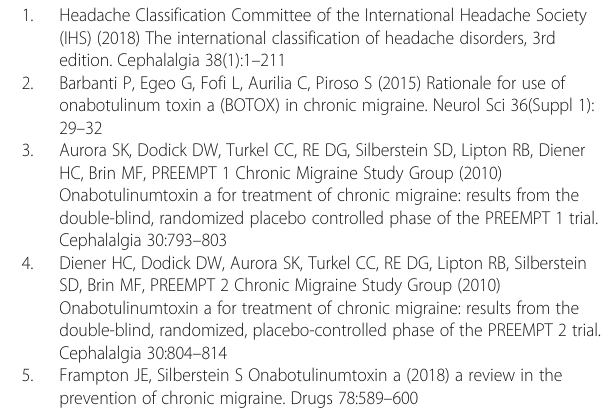
Abbreviations CGRP: Calcitonine Gene Related Peptide; CM: Chronic